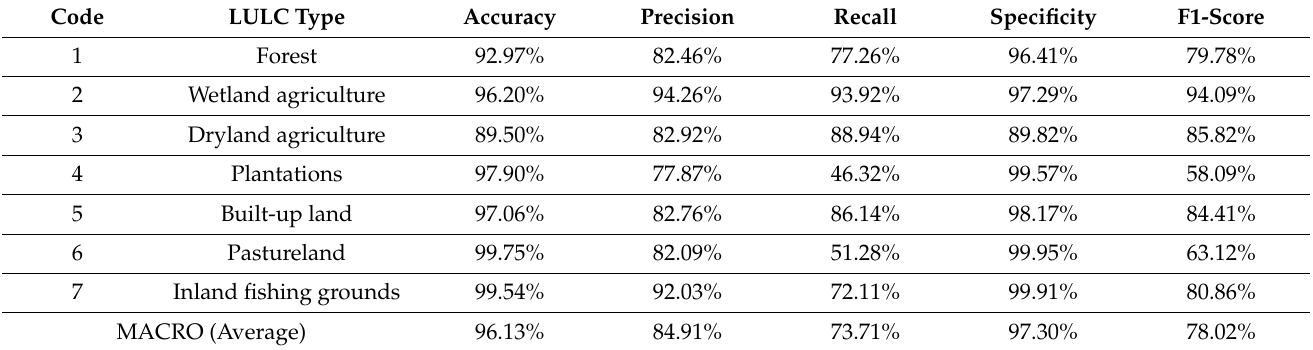
Table 9. The model performance of the land suitability model in Java Island using SVM.